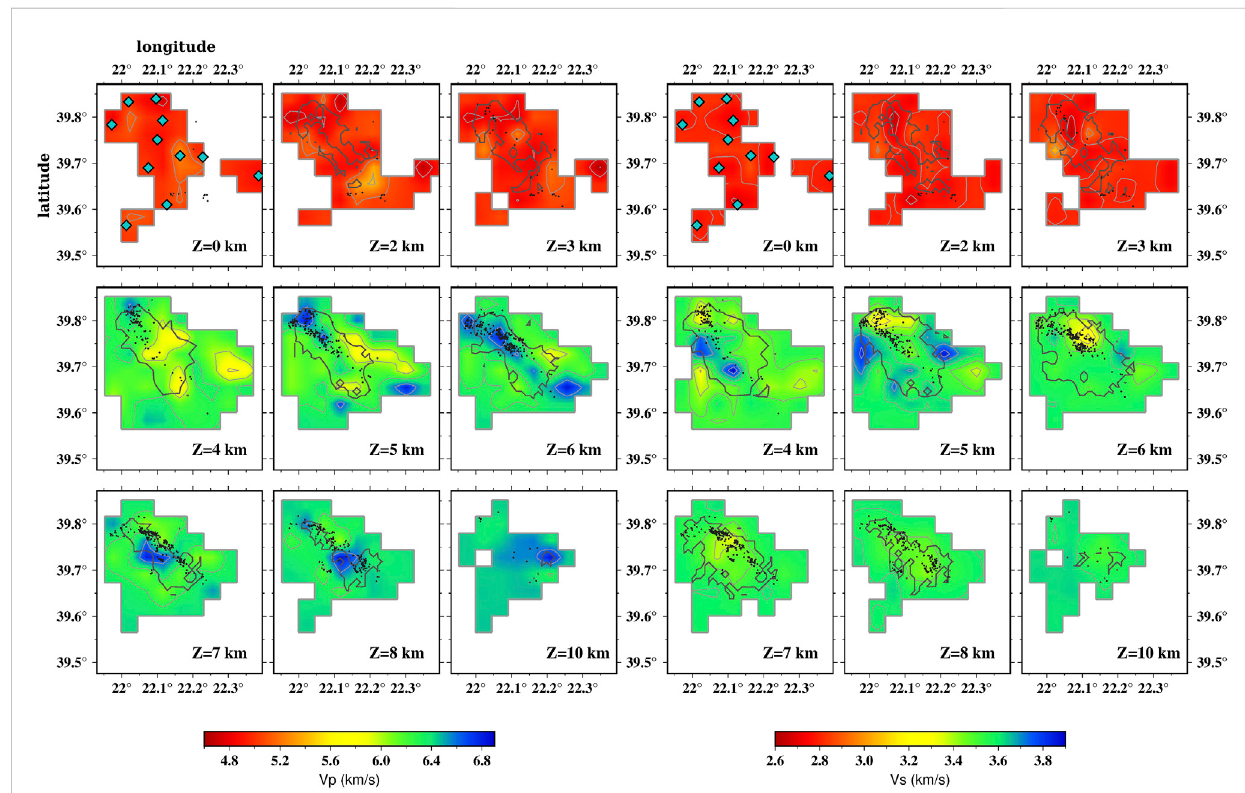
FIGURE 2 Horizontal slices for 0 – 10 km depths showing P- and S- wave velocity models (left and right panels, respectively). The used seismic stations are represented in the 0 km depth slice as cyan diamonds. Black dots represent the location of the seismic events achieved from the tomographic inversion procedure. Each slice includes the events below and above 500 m from the selected depth. Well-resolved areas are contoured by solid dark gray